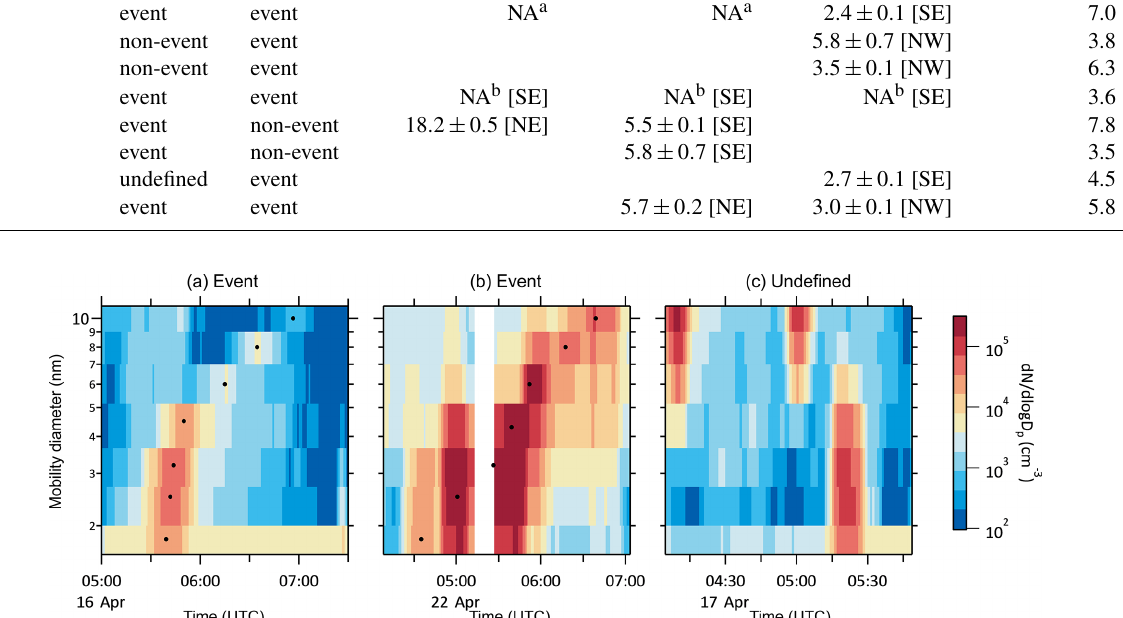
Figure 2. Three different patterns of the sub-10nm particle number size distribution measured with the DMA-train. Panel (a) shows the case of an event day exhibiting a growing mode diameter (black markers). A second event case is illustrated in panel (b) , where a new particle mode is formed and continues to grow beyond 10nm. Panel (c) shows an undefined day with a new particle mode forming which does not show signs of particle